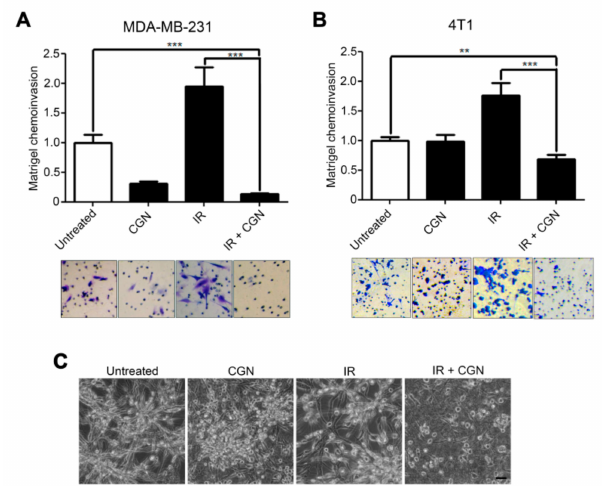
Figure 3. CGN inhibits the IR-induced invasive activity and 3D lrECM growth in breast cancer cells. ( A , B ) The invasive activity was measured by Matrigel chemoinvasion assay after IR and / or CGN treatments in MDA-MB-231 ( A ) and 4T1 ( B ) cells. Columns, mean ( n = 4); bars, SE. **, p < 0.01; ***, p < 0.001. ( C ) MDA-MB-231 cells were cultured in 3D lrECM. Bar, 50 µ